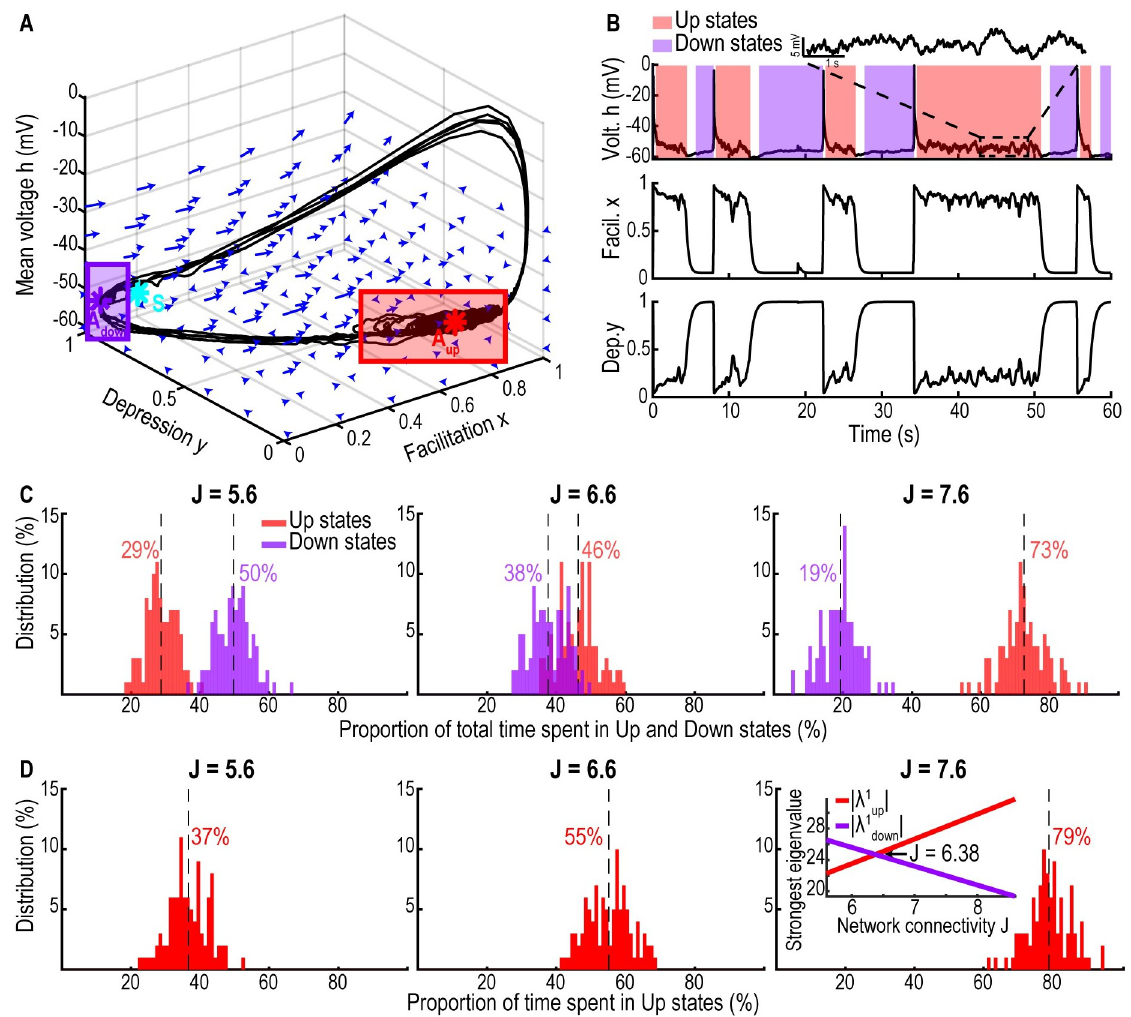
Fig 3. Single population exhibiting Up and Down states. A: 3D phase space of system (3) with the two attractors A (purple) and A Down Up (red) and the saddle-point S (cyan). The purple (resp. red) rectangle shows the subspace of Down (resp. Up) states. B: Time series of the mean voltage h (upper) showing Down (purple, resp. Up, red) states and an inset during the Up state, facilitation x (center) and depression y (lower, synaptic plasticity timescales: τ = 0.025s, τ r = 0.5s and τ f = 0.3s). C: Distributions of the fraction of time spent in Down t Down (purple, resp. Up t Up , red) states for network connectivity J = 5.6 (left), 6.6 (center) and 7.6 (right) for 1000 minutes simulations. Vertical dotted lines indicate for the three values of J . Inset: strongest attractive mean values. D: Distribution of the fraction of the total time spent in Up state t Up t Up þ t Down eigenvalue of the Down state j l 1 j (purple, resp. Up state, j l 1 j , red) with respect to the network connectivity J . A Down A Up